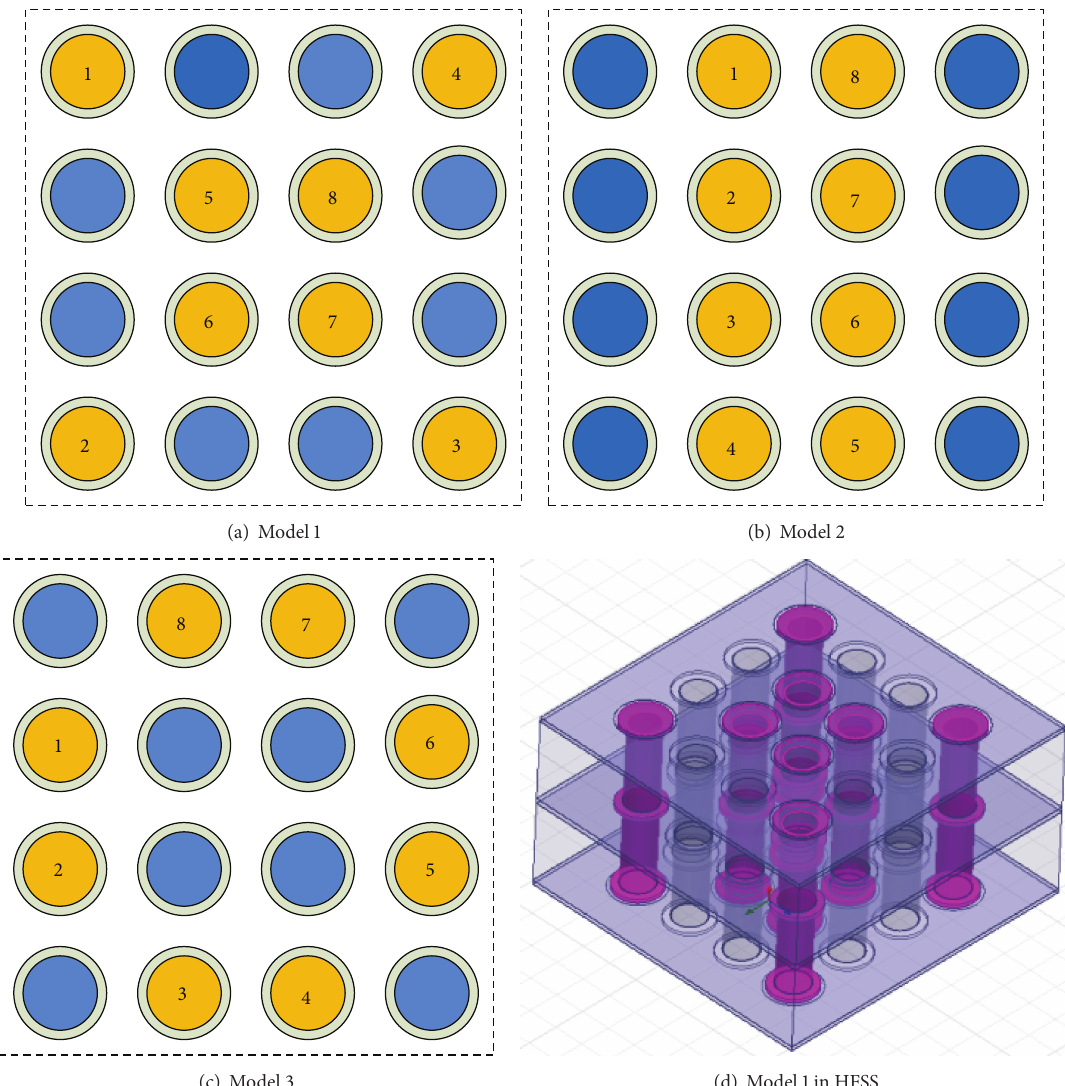
Figure 13: Three different GS distribution models of multilayer TSV array: blue indicates the ground TSV and yellow indicates the signal